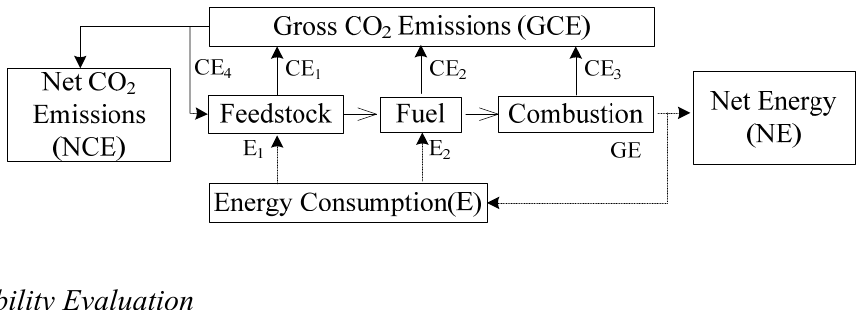
emissions in the production system of Jatropha biodiesel. 2